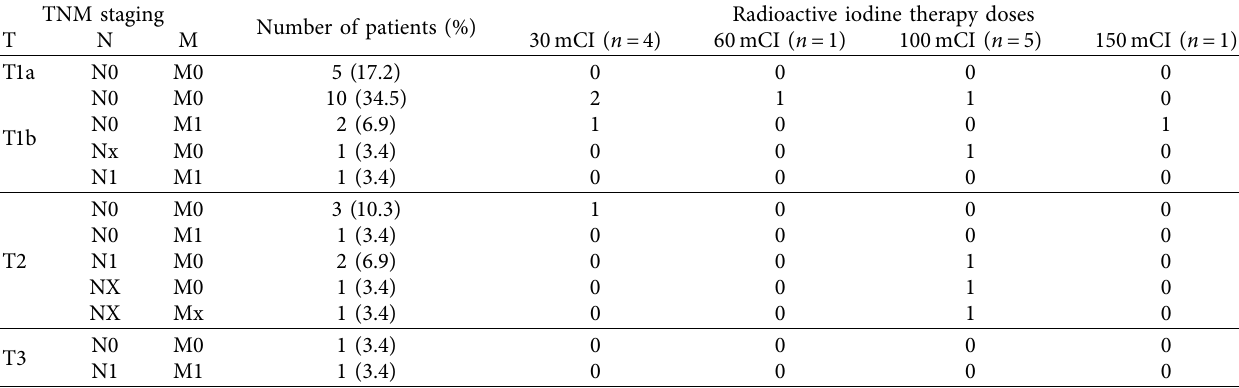
Table 3: TNM staging details of patients.